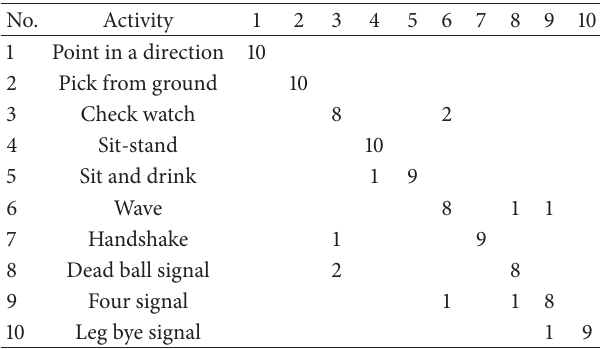
Table 4: Confusion matrix for activity recognition when using automatic selection of